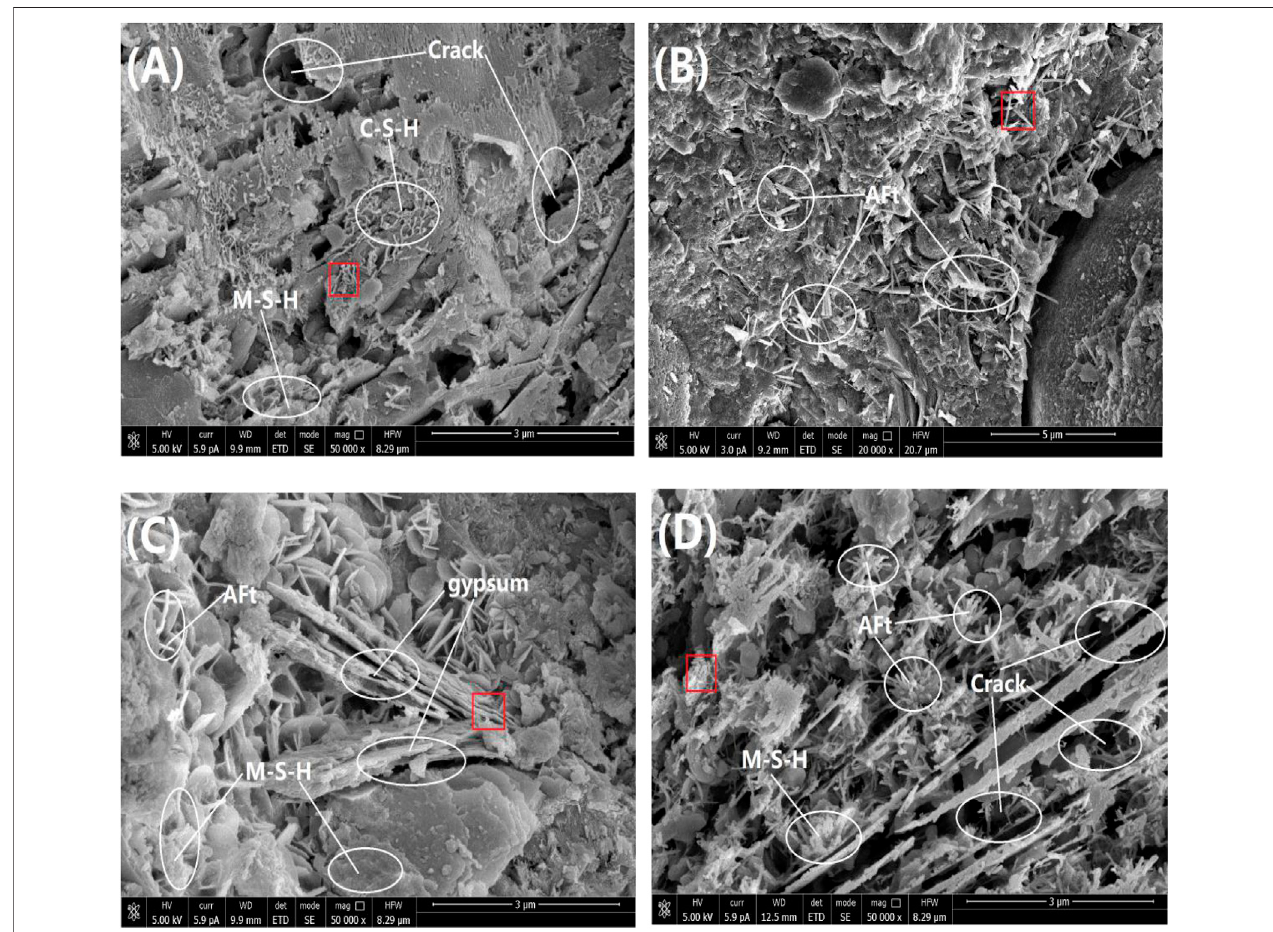
FIGURE 7 | Microscopic morphology of each group of concrete with 120 cycles: (A) MK0; (B) MK5; (C) MK10; (D) MK15.